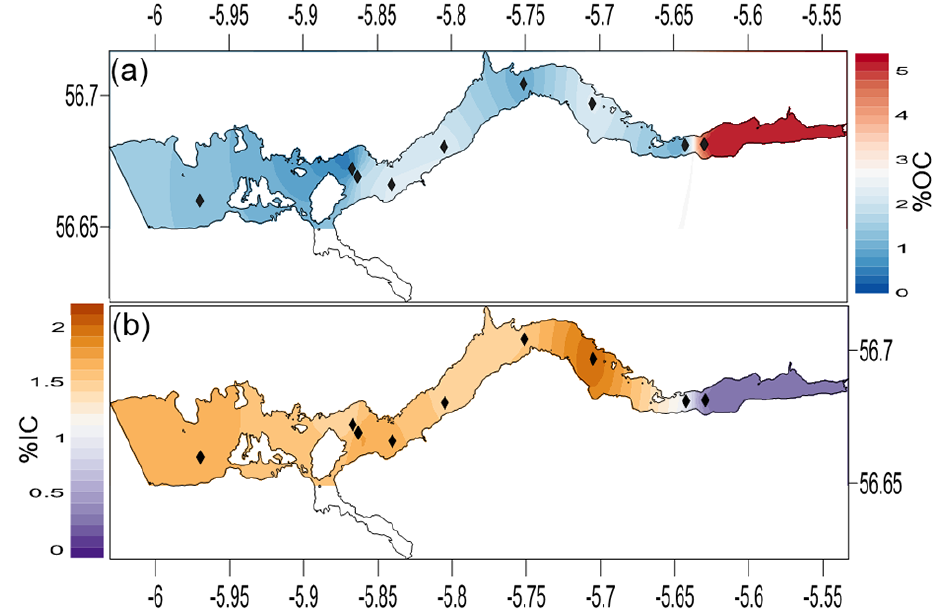
Figure 7. Output of U3 spatial distribution model for (a) organic carbon (OC) and (b) inorganic carbon (IC). Sampling locations indicated with black